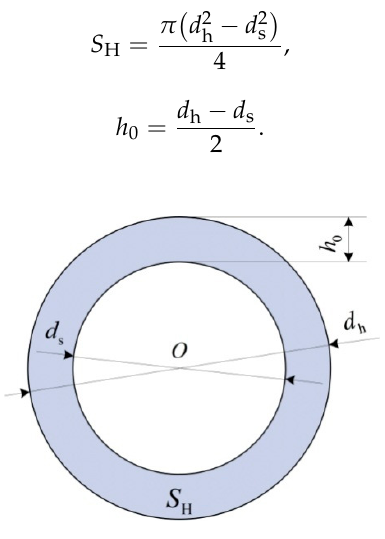
Figure 7. Physical area of the orifice in the horizontal direction.